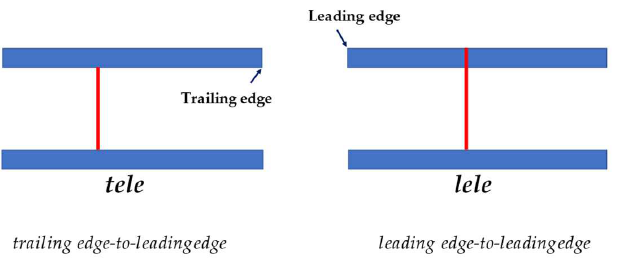
Figure 3. A schematic representation of two measurement methods used to determine right pulmo- nary artery diameter at each measurement site. tele, trailing edge-to-leading edge; lele, leading edge-to-leading edge.